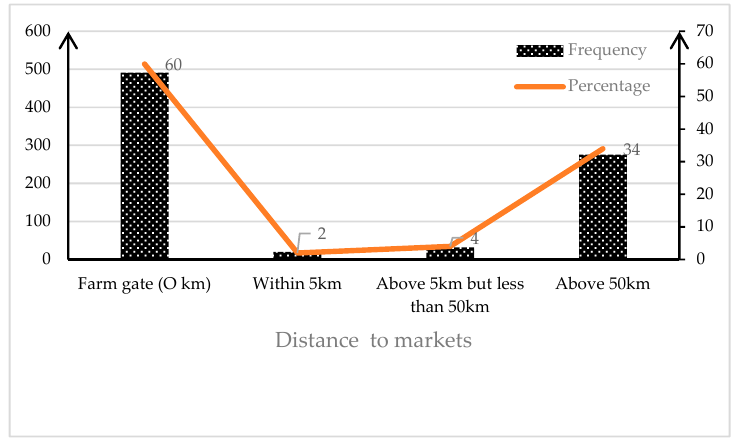
Figure 1. Distance to markets accessed by farming households.